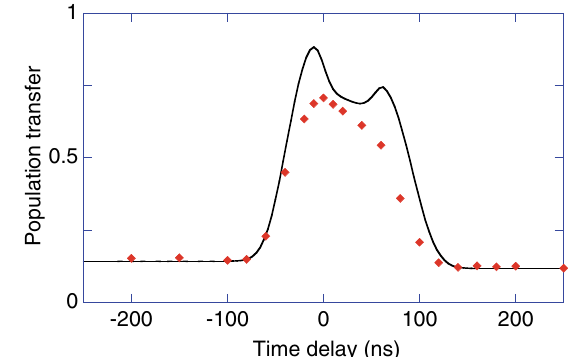
FIG. 4. The population transfer to the F ¼ 2 level (i.e., jh c j F ¼ 2 ij 2 ) as a function of the time delay between the probe and the coupling laser beams. The zero time delay point corre- sponds to overlapping the probe and coupling lasers, with both beams turning off simultaneously. The solid line is a numerical simulation of the density matrix with a single adjustable parameter. See text for